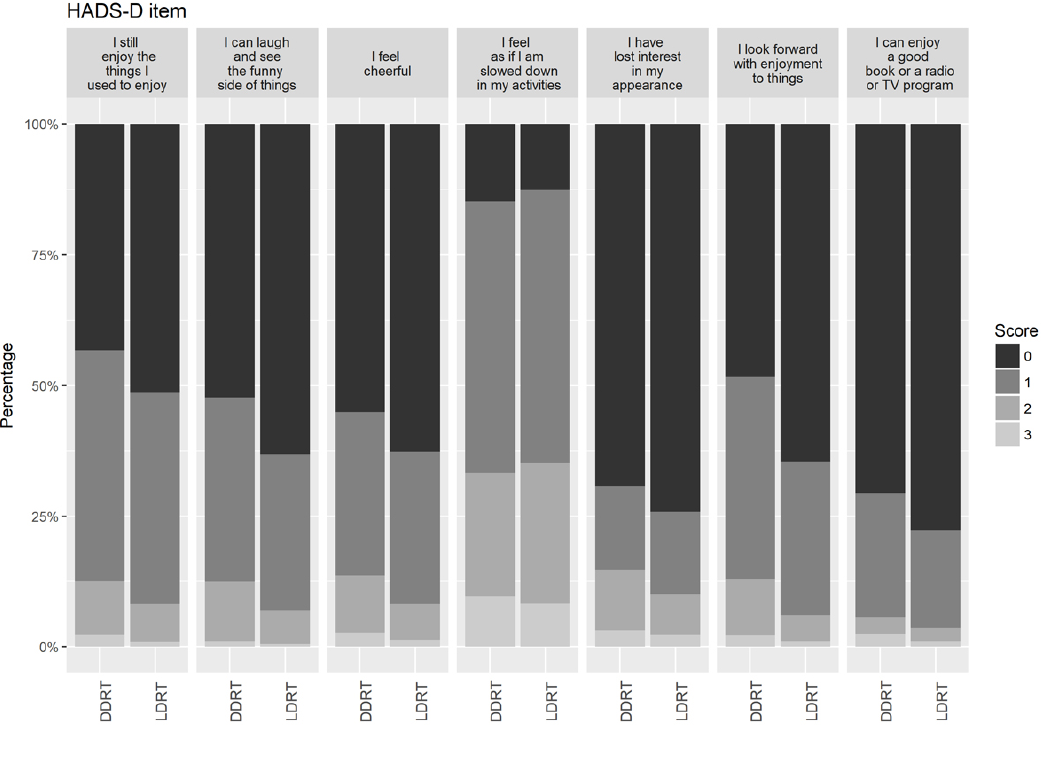
Figure S1: Bar plot of percentages of scores for hospital anxiety and depression score by DDRT and LDRT renal transplant candidates for items related to depression. n = 1766. Score 0 indicates no impairment, score 3 severe impairment. DDRT = deceased donor renal transplant; HADS = hospital anxiety and depression scale; LDRT = living donor renal